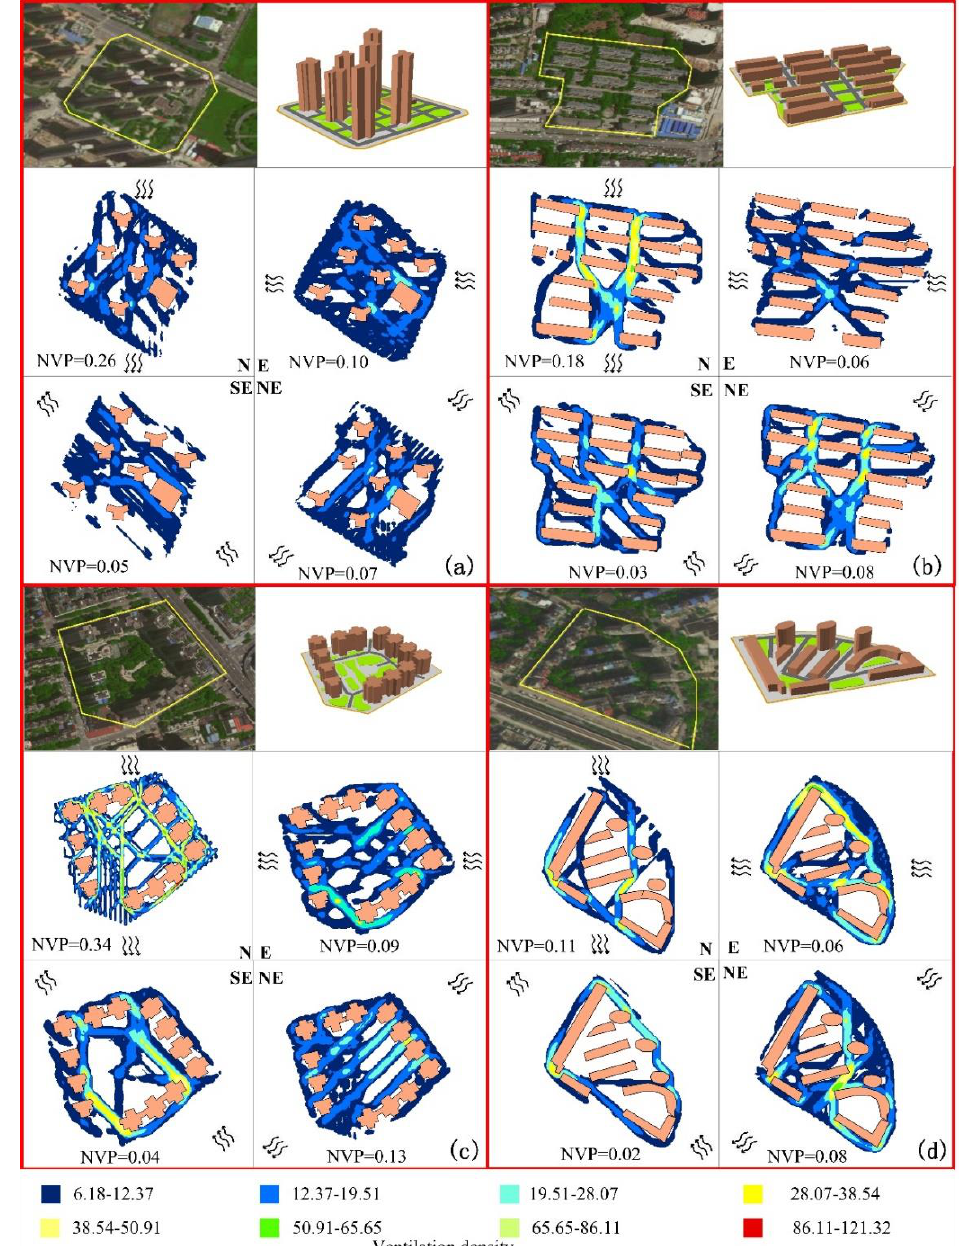
Figure 2. Spatial layout of four representative residential areas: ( a ) points layout, ( b ) parallel layout, ( c ) center-around layout, ( d ) mixed layout; the density of ventilation corridors, and the NVP of each wind downward (N: north wind; E: east wind, SE: southeast wind, NE: northeast wind).